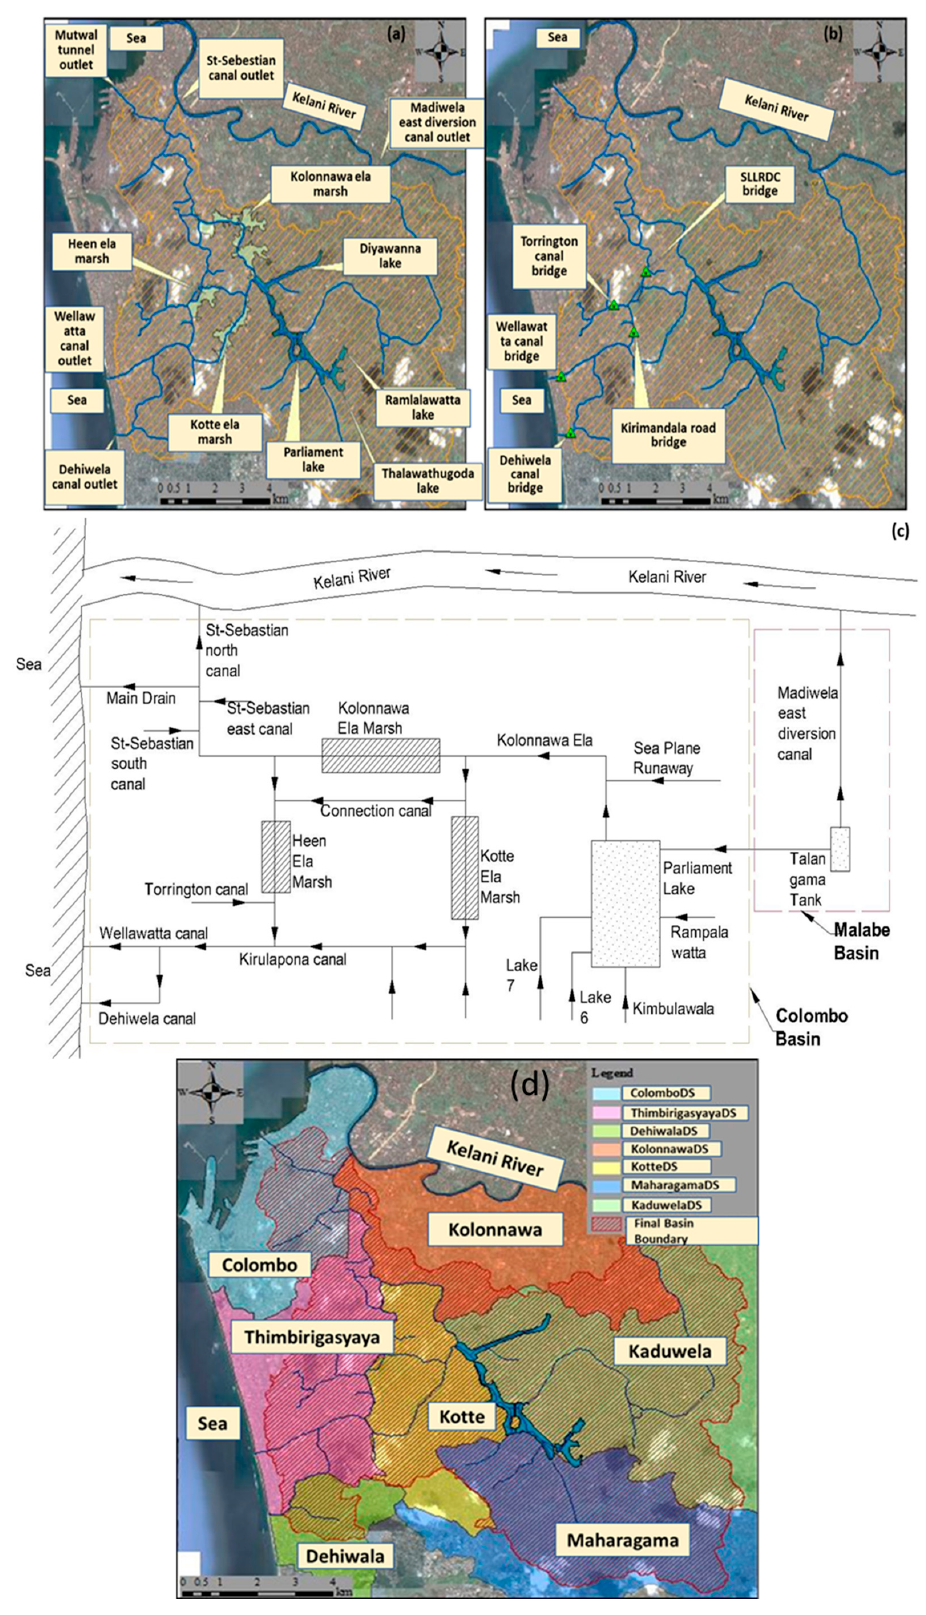
Figure 3. ( a ) Description of the Metro Colombo canal basin; ( b ) Water level gauging stations; ( c ) Schematic diagram of the Metro Colombo canal basin; ( d ) Divisional Secretary’s Divisions (DSDs) in the basin.